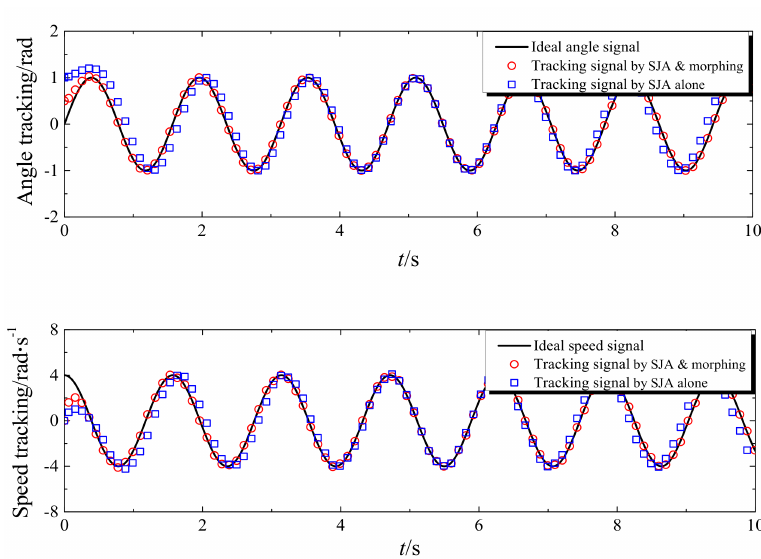
Figure 13. Angle and speed tracking response.